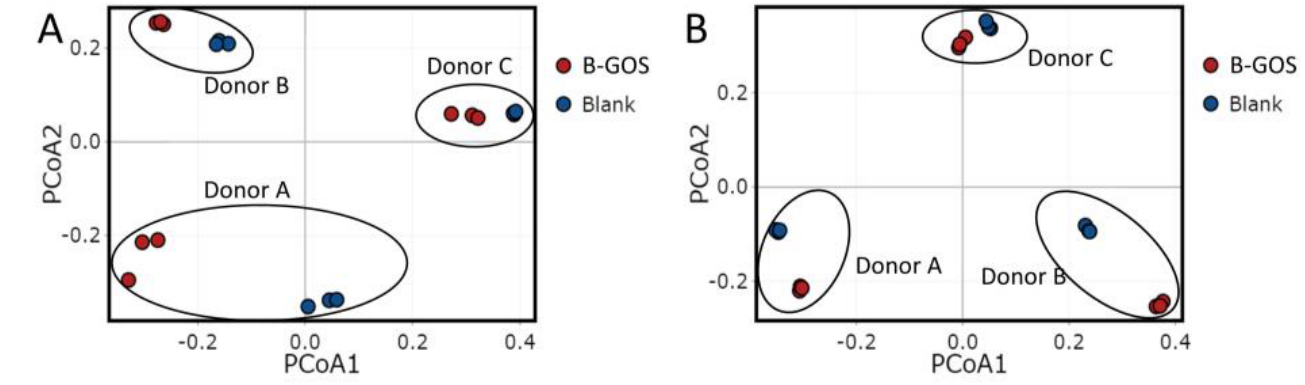
Figure 4. Principal Coordinate Analysis of species data using Bray–Curtis distance for each donor at ( A ) 6 h after treatment (relative data) and ( B ) 24 h after treatment (absolute data). Each dot represents one replicate. GOS = Bimuno ® galactooligosaccharide.